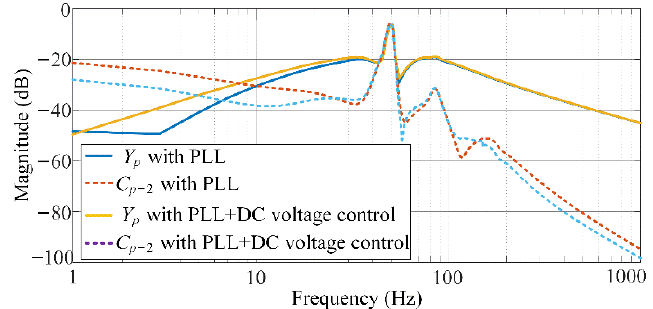
Figure 19. Bode diagrams of the MMC admittances with and without the DC-bus voltage controller. Table 3. Significance evaluation of frequency coupling.